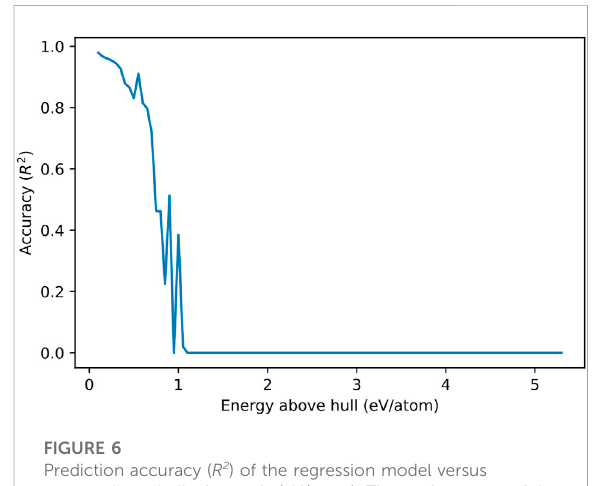
FIGURE 6 Prediction accuracy ( R 2 ) of the regression model versus energy above hull of crystals (eV/atom). The performance of the model was calculated on crystals with steps of 0.05 eV/atom. The performance decreases far below 0, but a minimum of 0 is applied on the graph for the sake of